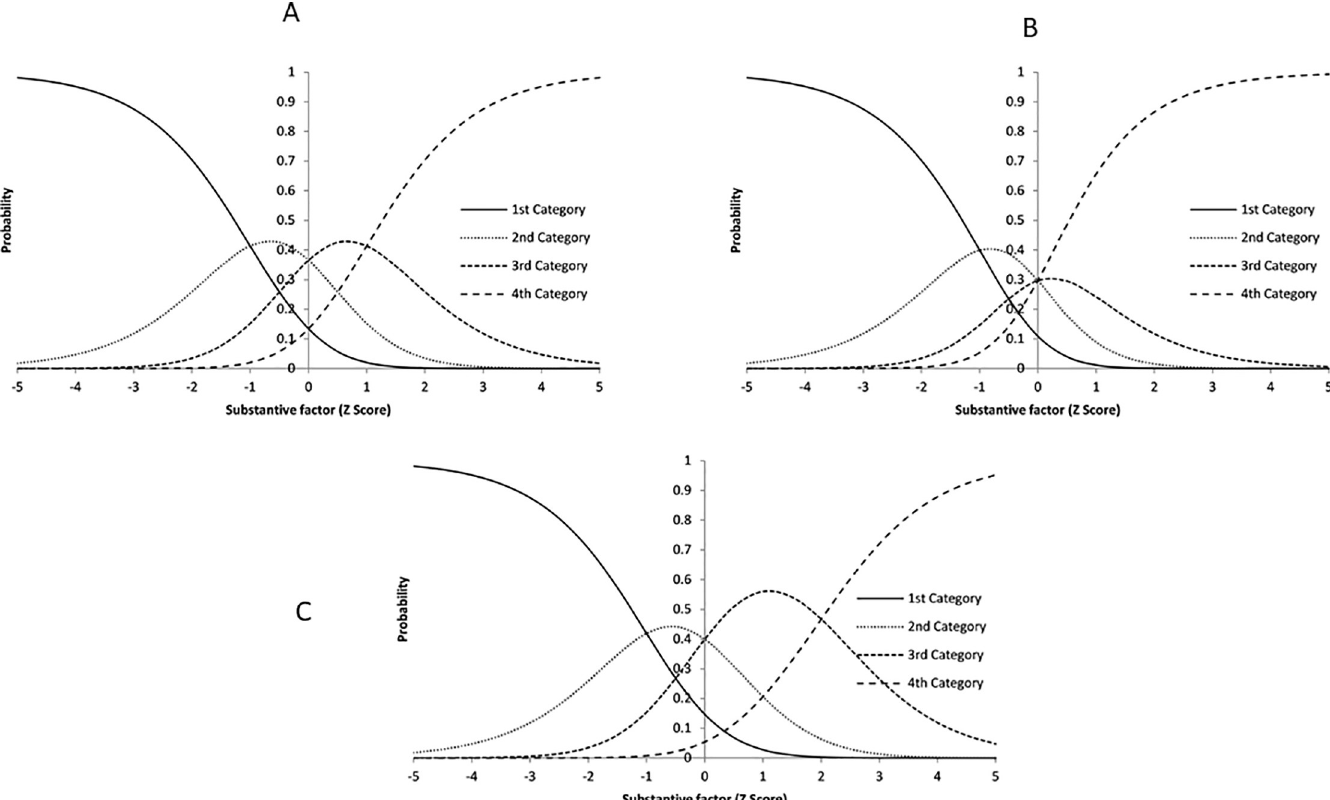
Fig 1. Example of response category curves with different PERS levels. (A) Category Characteristic Curves without PERS bias ( θ PERS = 0). (B) Category Characteristic Curves with positive PERS bias ( θ = 1). (C) Category Characteristic Curves with negative PERS bias ( θ PERS